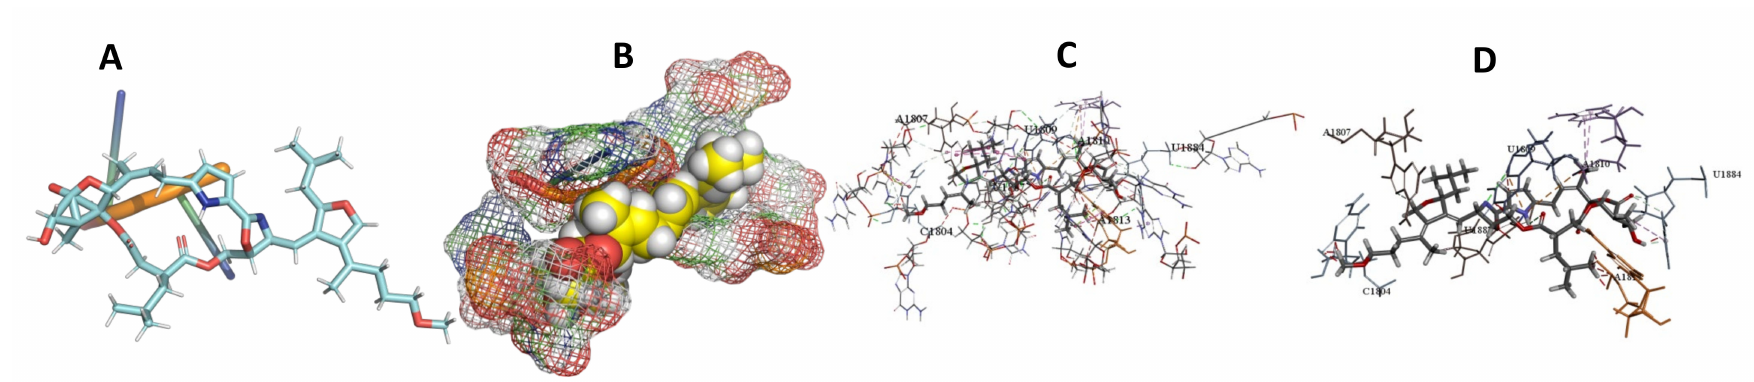
Figure 22. T. cruzi + leupyrin. ( A ): Best binding pose and nucleotides involved. ( B ): Schematic binding pocket. ( C ): shows the Nucleotides component that re involved in binding. ( D ): Shows the main bonds involved between the compound and the nucleotide component.